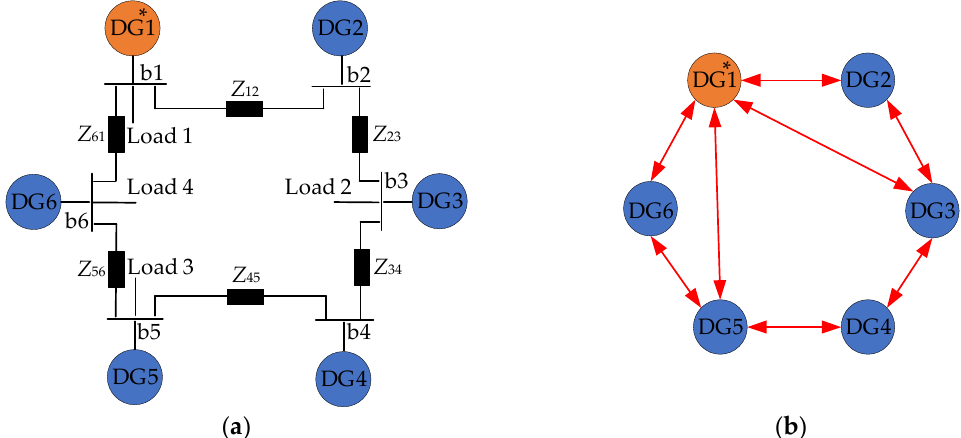
Figure 3. The power connection topology and communication connection topology of the system: (nodes with * are pinning nodes, the same below) ( a ) power connection topology; ( b ) communication connection topology.